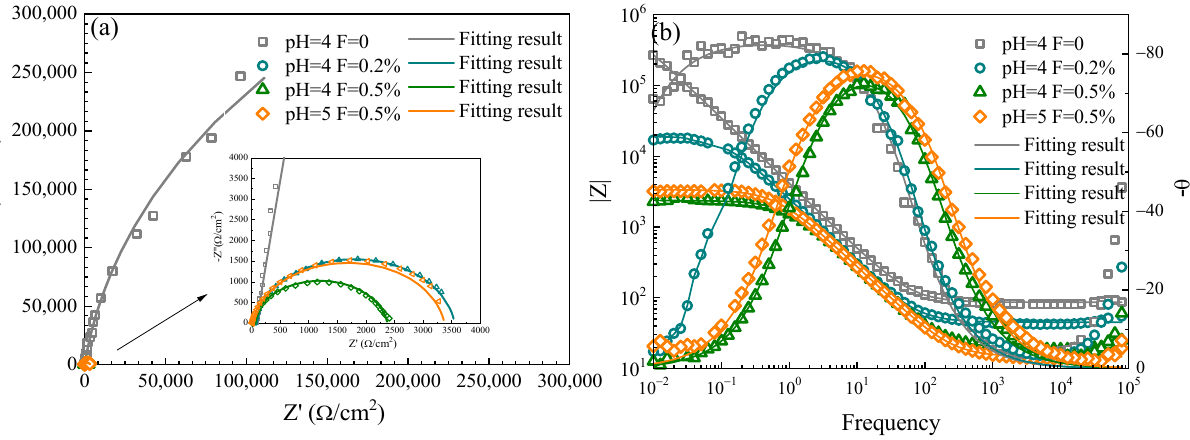
Figure 7. EIS diagram of SLM sample in ASS with different pH values and F − concentrations. ( a ) Nyquist; ( b ) Bode. Table 2. EIS fitting parameters of SLM and wrought TiNi sample in ASS.